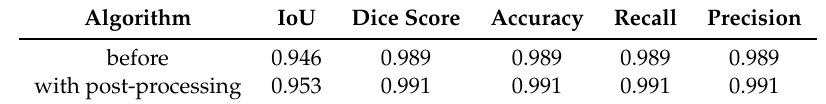
Table 7. Metrics measured before and after applying the post-processing step on the FC-DenseNet103 network. Algorithm IoU Dice Score Accuracy Recall Precision before 0.946 0.989 0.989 0.989 0.989 with post-processing 0.953 0.991 0.991 0.991 0.991